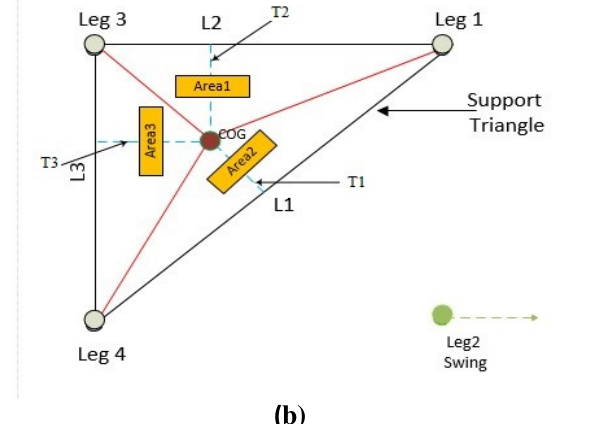
Fig. 9. Quadruped robot when leg2 is swinging (a) quadruped robot 3D view (b) Quadruped support triangle.